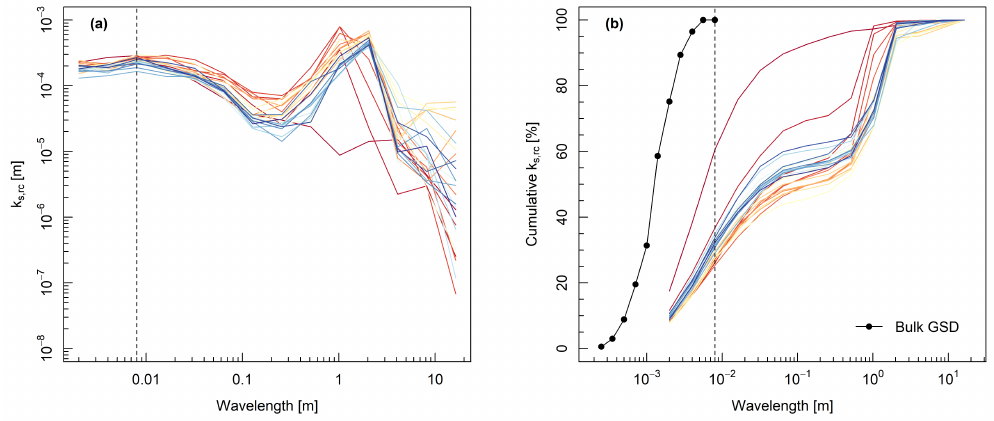
Figure 8. Drag size distribution over the course of Experiment 1a. The estimated roughness length of each topographic wavelength presented as an (a) absolute and (b) cumulative percentage. Refer to Fig. 6 for legend.